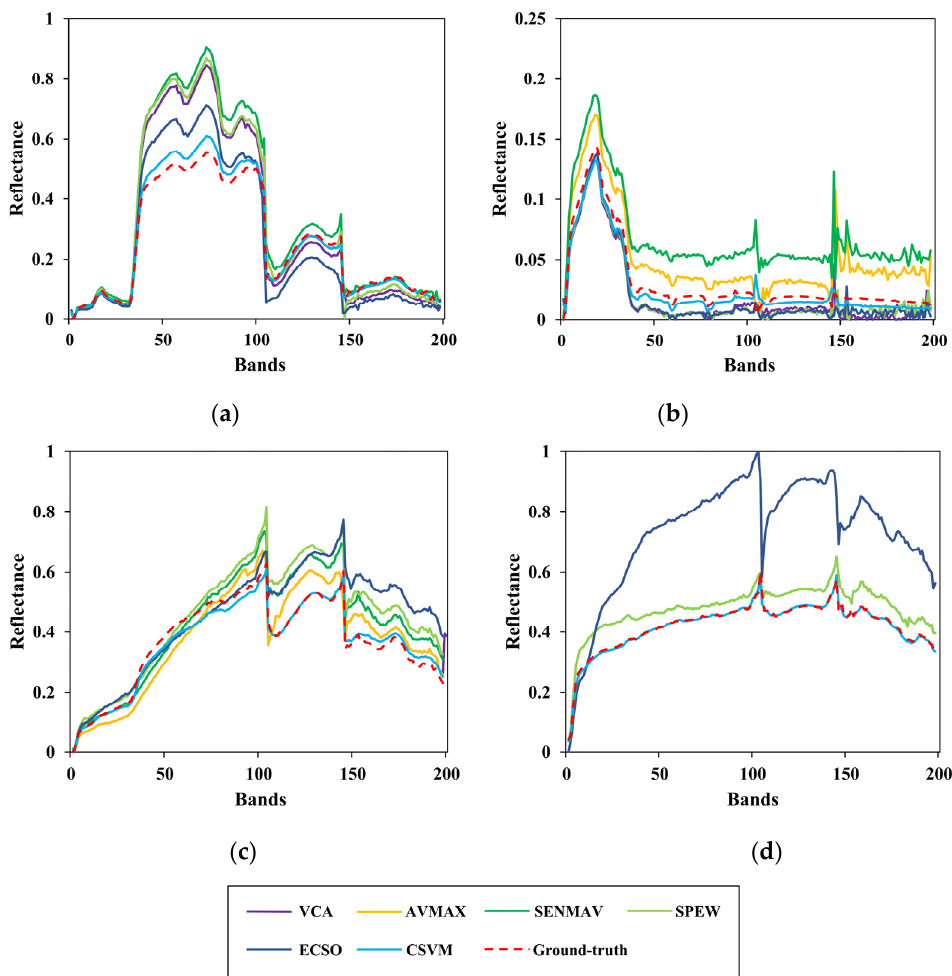
Figure 11. Comparison between the estimated and ground-truth endmember spectral signatures on Samson. ( a ) Soil; ( b ) tree; ( c ) water.